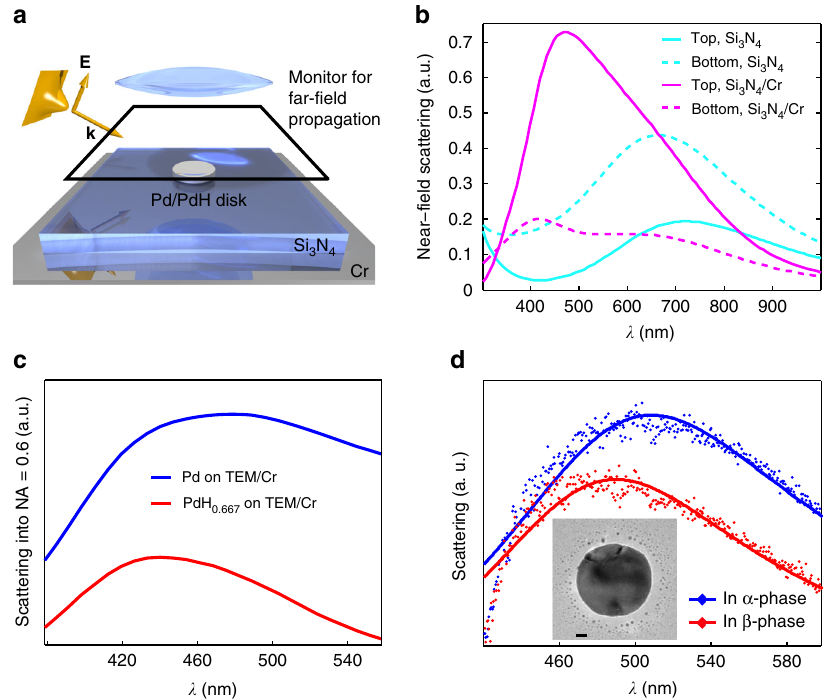
Fig. 2 Finite difference time domain (FDTD) simulations. a Artist ’ s rendition of the simulation scheme, where a Pd/PdH x nanodisk is placed on top of a 40 nm silicon nitride layer with a 10 nm Cr mirror below. A broadband Gaussian beam with TM polarization is incident onto the disk at 55° to mimic the dark- fi eld illumination conditions of the plasmonic nanospectroscopy experiment. A combined scattered and re fl ected signal is collected above the structure and the Gaussian source, and then propagated into the far fi eld, where it is analyzed. The re fl ected Gaussian beam is subtracted to obtain the scattered signal, which is integrated in the conical angle set by the numerical aperture of the collection lens and constitutes the “ measured ” signal in simulations. b Calculated backward and forward-directed scattering from a Pd nanodisk (diameter 140 nm, thickness 30 nm) placed on a TEM window in presence and absence of the Cr mirror layer underneath the membrane. The placement of the Cr mirror increases the backward/forward scattering ratio by a factor of ca. 6. c Calculated backward scattering into an objective with N.A. = 0.6 of a Pd nanodisk in the metallic ( blue line ) and fully hydrided ( red line ) state located on a TEM window with Cr mirror layer. d Corresponding experimentally measured dark- fi eld scattering spectra of a Pd nanodisk located on a TEM window with Cr mirror layer in the metallic ( blue line ) and fully hydrided ( red line ) state. The scale bar in the inset TEM image of the Pd nanodisk is 20